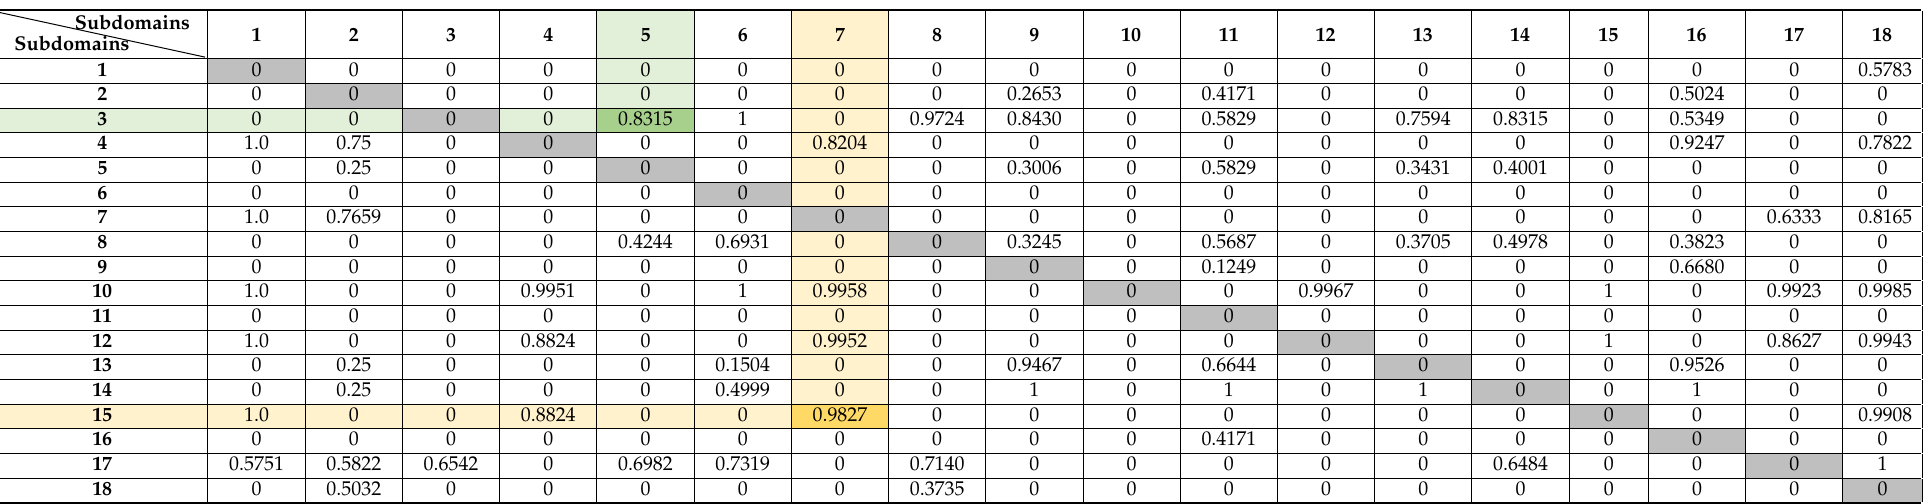
Table 19. Use-case Conditional Probabilities Table (CPT) for CO 2 sensor